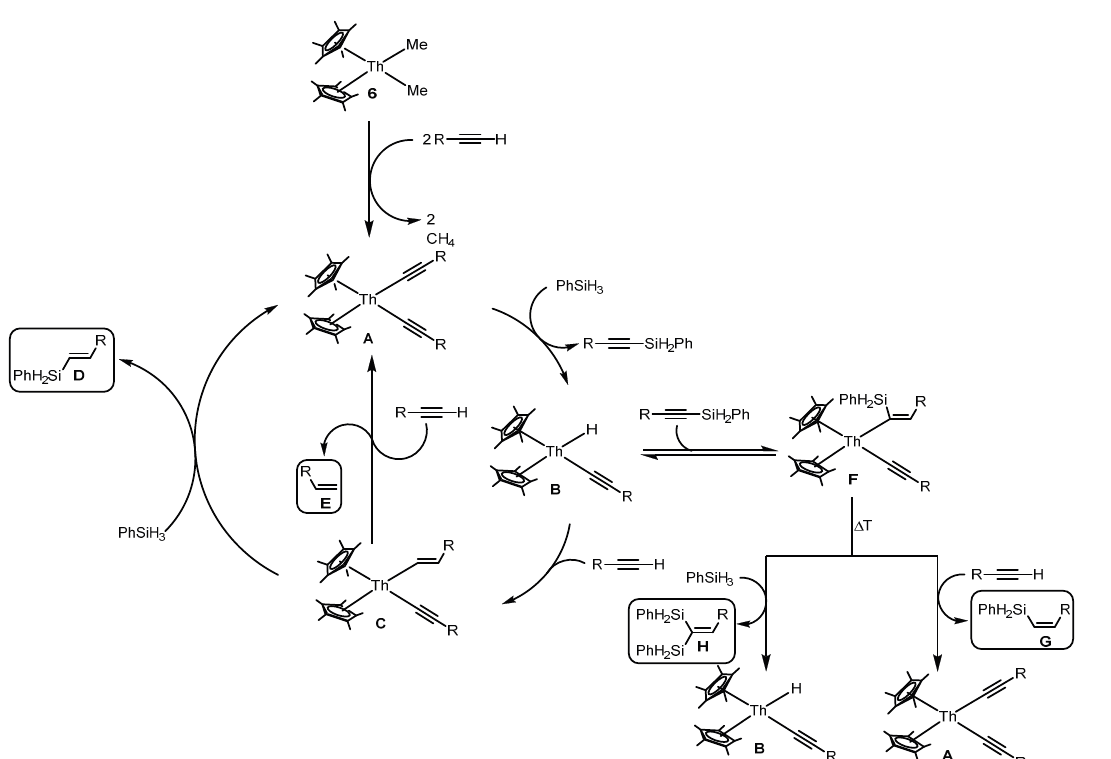
Scheme 8. Proposed mechanism for the hydrosilylation of terminal alkynes, mediated by Cp* 2 ThMe 2 ( 6 ). Adapted with permission from Dash, A.K.; Wang, J.Q.; Eisen,